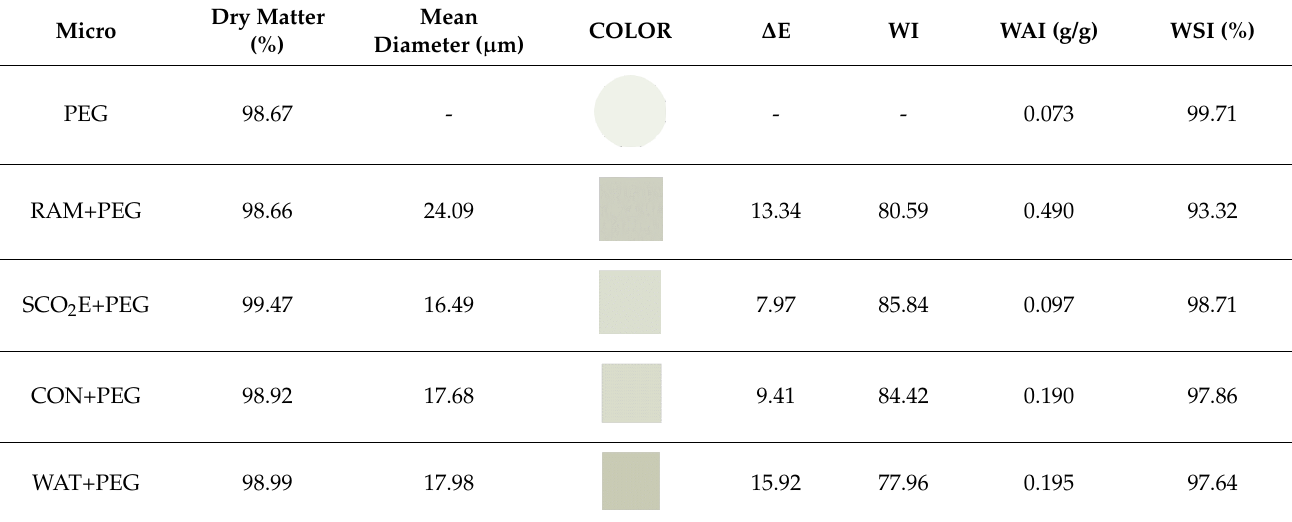
Table 3. Dry matter and physical properties for pigment microparticles obtained with the PGSS process.